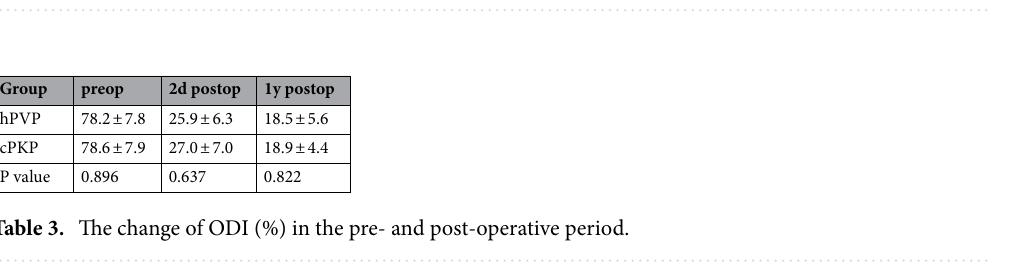
Table 2. The change of VAS for back pain in the pre-and post-operative period.